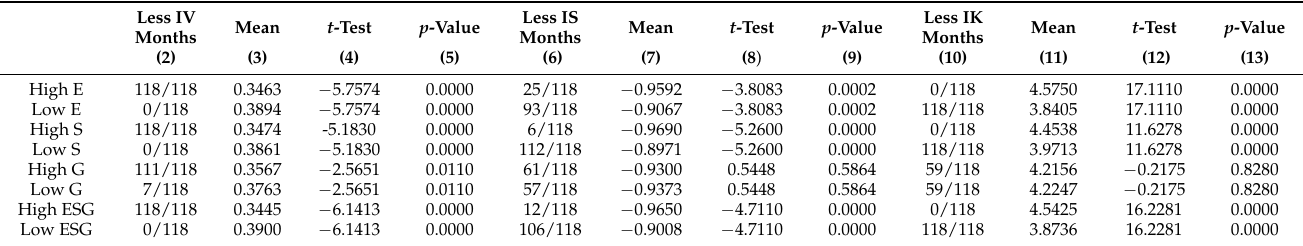
Table 2. Number of months where implied moments of companies in either high or low ESG rating groups is the lower of the